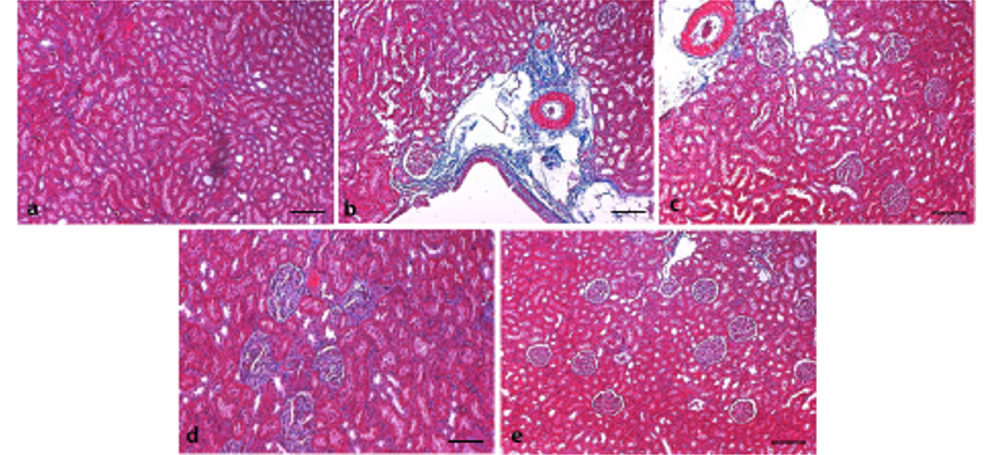
Figure 7. Masson trichrome staining. Masson’s trichrome staining was showing that ( a ): Normal kidney architecture show- ing no collagen deposition; ( b ): significant increase in collagen deposition in animals treated with STZ was noticed; ( c ): Following treatment with gingerol and STZ treated group collagen deposition was reduced as compared to the disease control group, ( d ): positive control (diabetic rats treated with glibenclamide) not showing any collagen deposition, ( e ): Gingerol-treated group only did not show deposition of collagen. (Scale bar = 100 μ m)